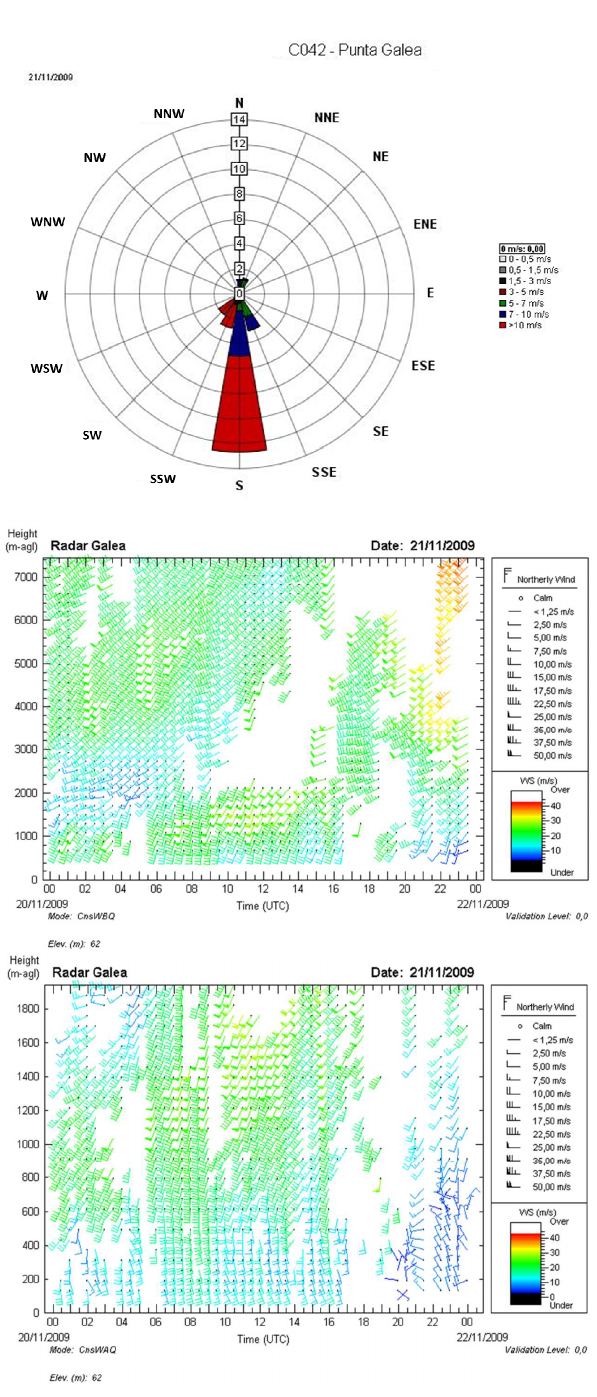
Fig. 10. South pattern: meteorological observations on 21 November 2009. Top panel, Wind rose derived from the automatic weather station (AWS). Middle panel, Barb plot for High mode observation with resolution of 200m. X axis (Time UTC). Y axis (Height in meters above ground level). Bottom panel, Low mode observation with higher resolution of 60m. X axis (Time UTC). Y axis (Height in meters above ground level).